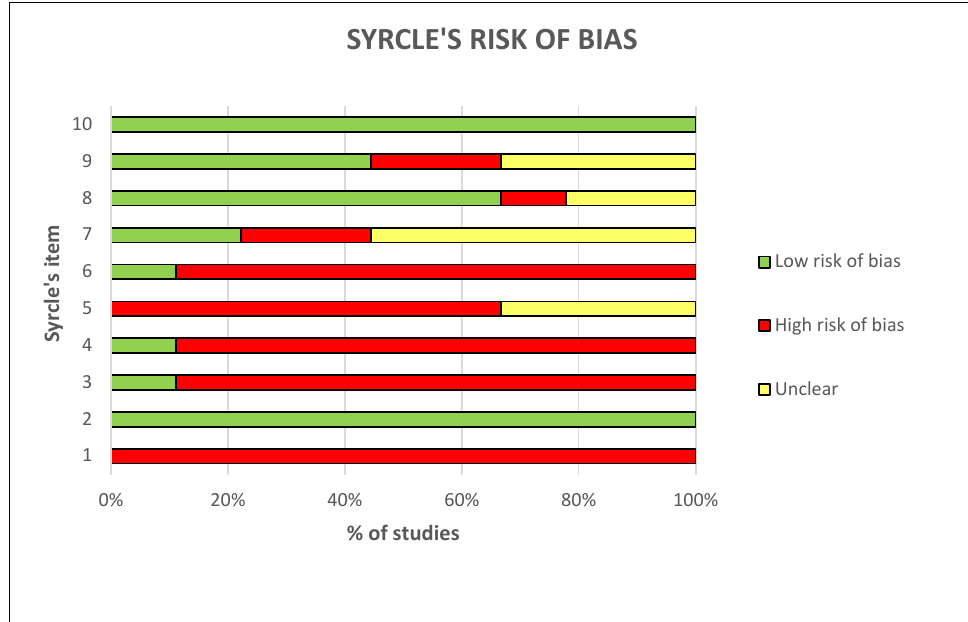
Figure 5. Each in vivo paper has been evaluated for the risk of bias by applying the SYRCLE’s tool [29]. For each of the 10 items, the frequency % of the low risk of bias (green bar), high risk of bias (red bar), and unclear risk of bias (yellow bar) is reported.